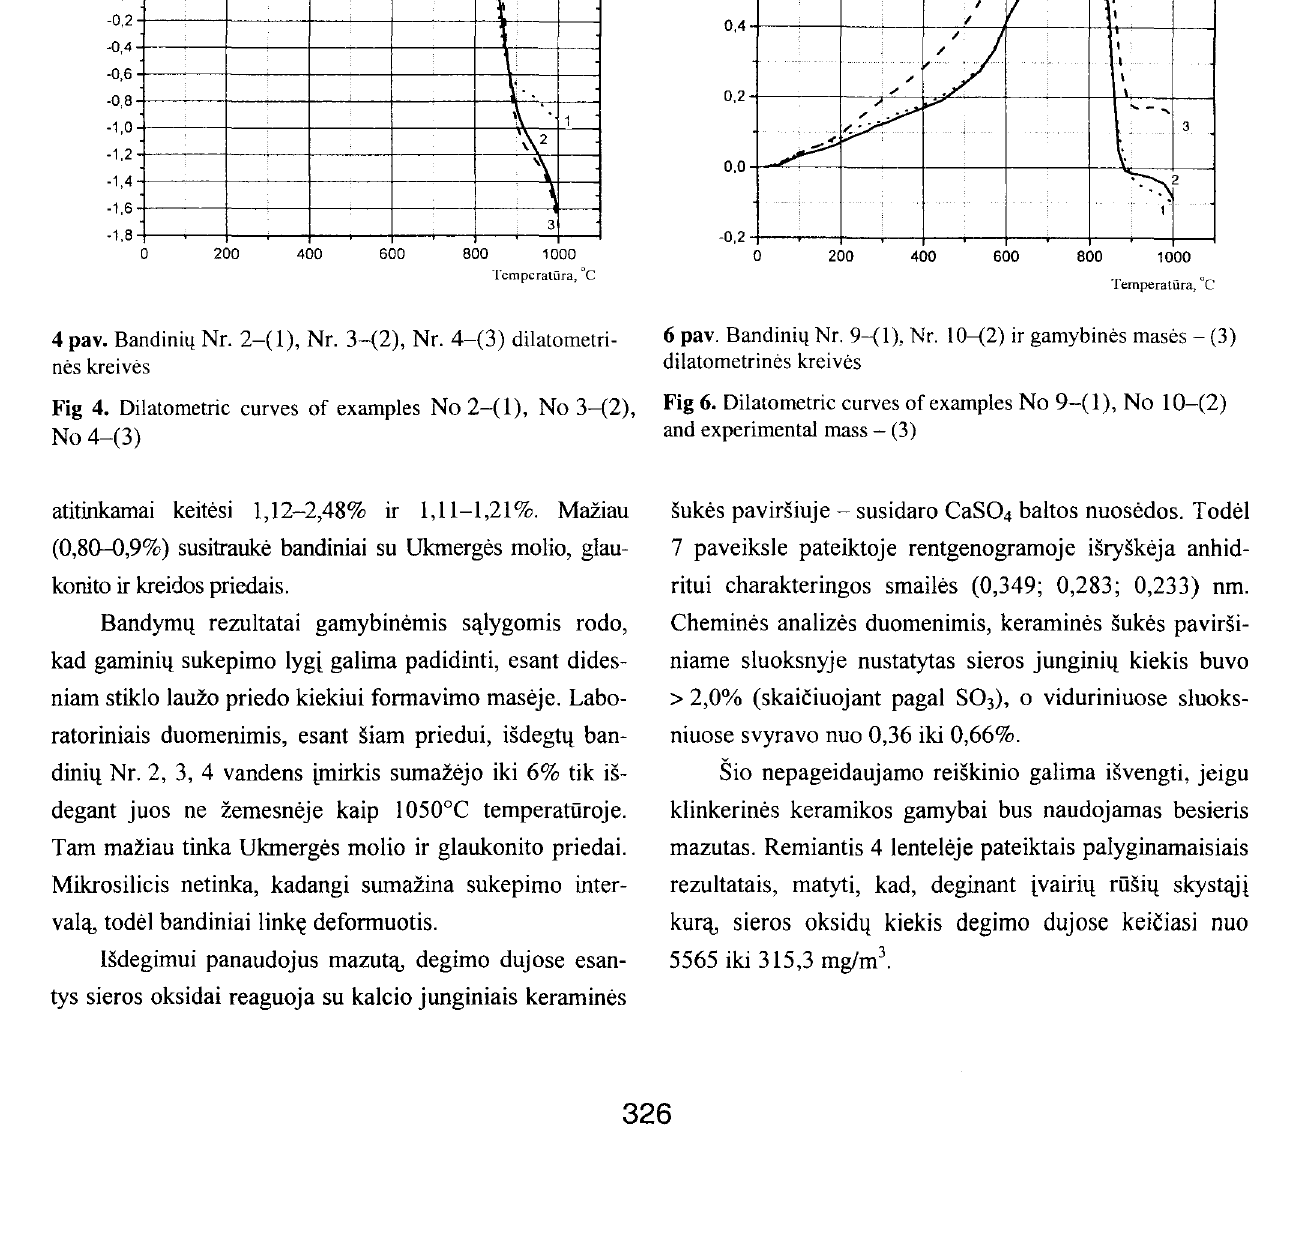
Fig 5. Dilatometric curves of examples No 5-(1), No 6-(2), No 7-(3) <f 0,8 .~